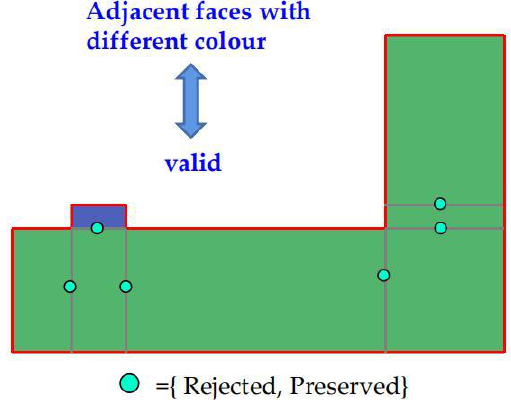
Figure 3. Illustration of the selection of valid edges.